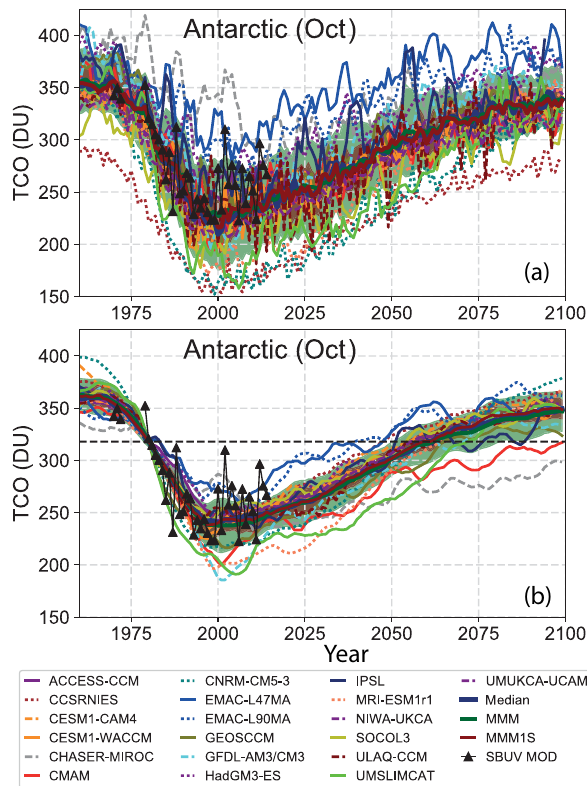
Figure 1. (a) Total column ozone time series (DU) for Antarc- tic in October from 19 individual CCMs for the REF-C2 simula- tions along with observations from the Solar Backscatter Ultravio- let (SBUV) merged ozone dataset (MOD) (Frith et al., 2017). The MMM, MedM, and MMM1S are shown with thick green, blue, and red lines, respectively. The light blue shaded region indicates the 10th and 90th percentile range. Light green and red regions show 1 σ variability with respect to MMM and MMM1S lines, respec- tively. (b) Same as panel (a) but adjusted total ozone time series with respect to mean 1980–1984 observations and after application of 10-point boxcar smoothing. The dashed black line indicates 1980 reference